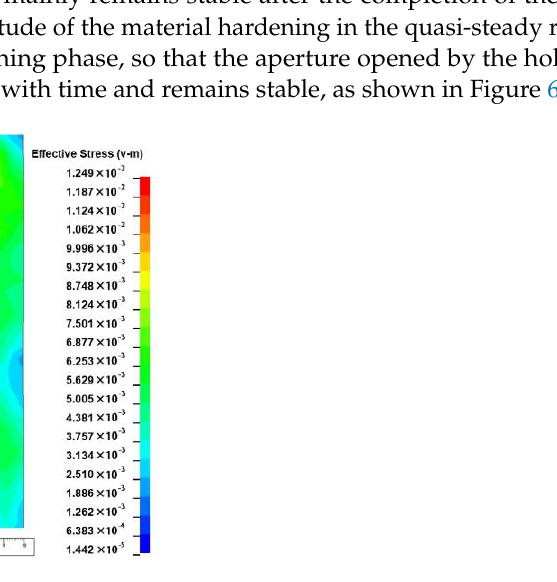
Figure 6. Schematic diagram of the jet aperture during the quasi-stationary phase of jet penetra-